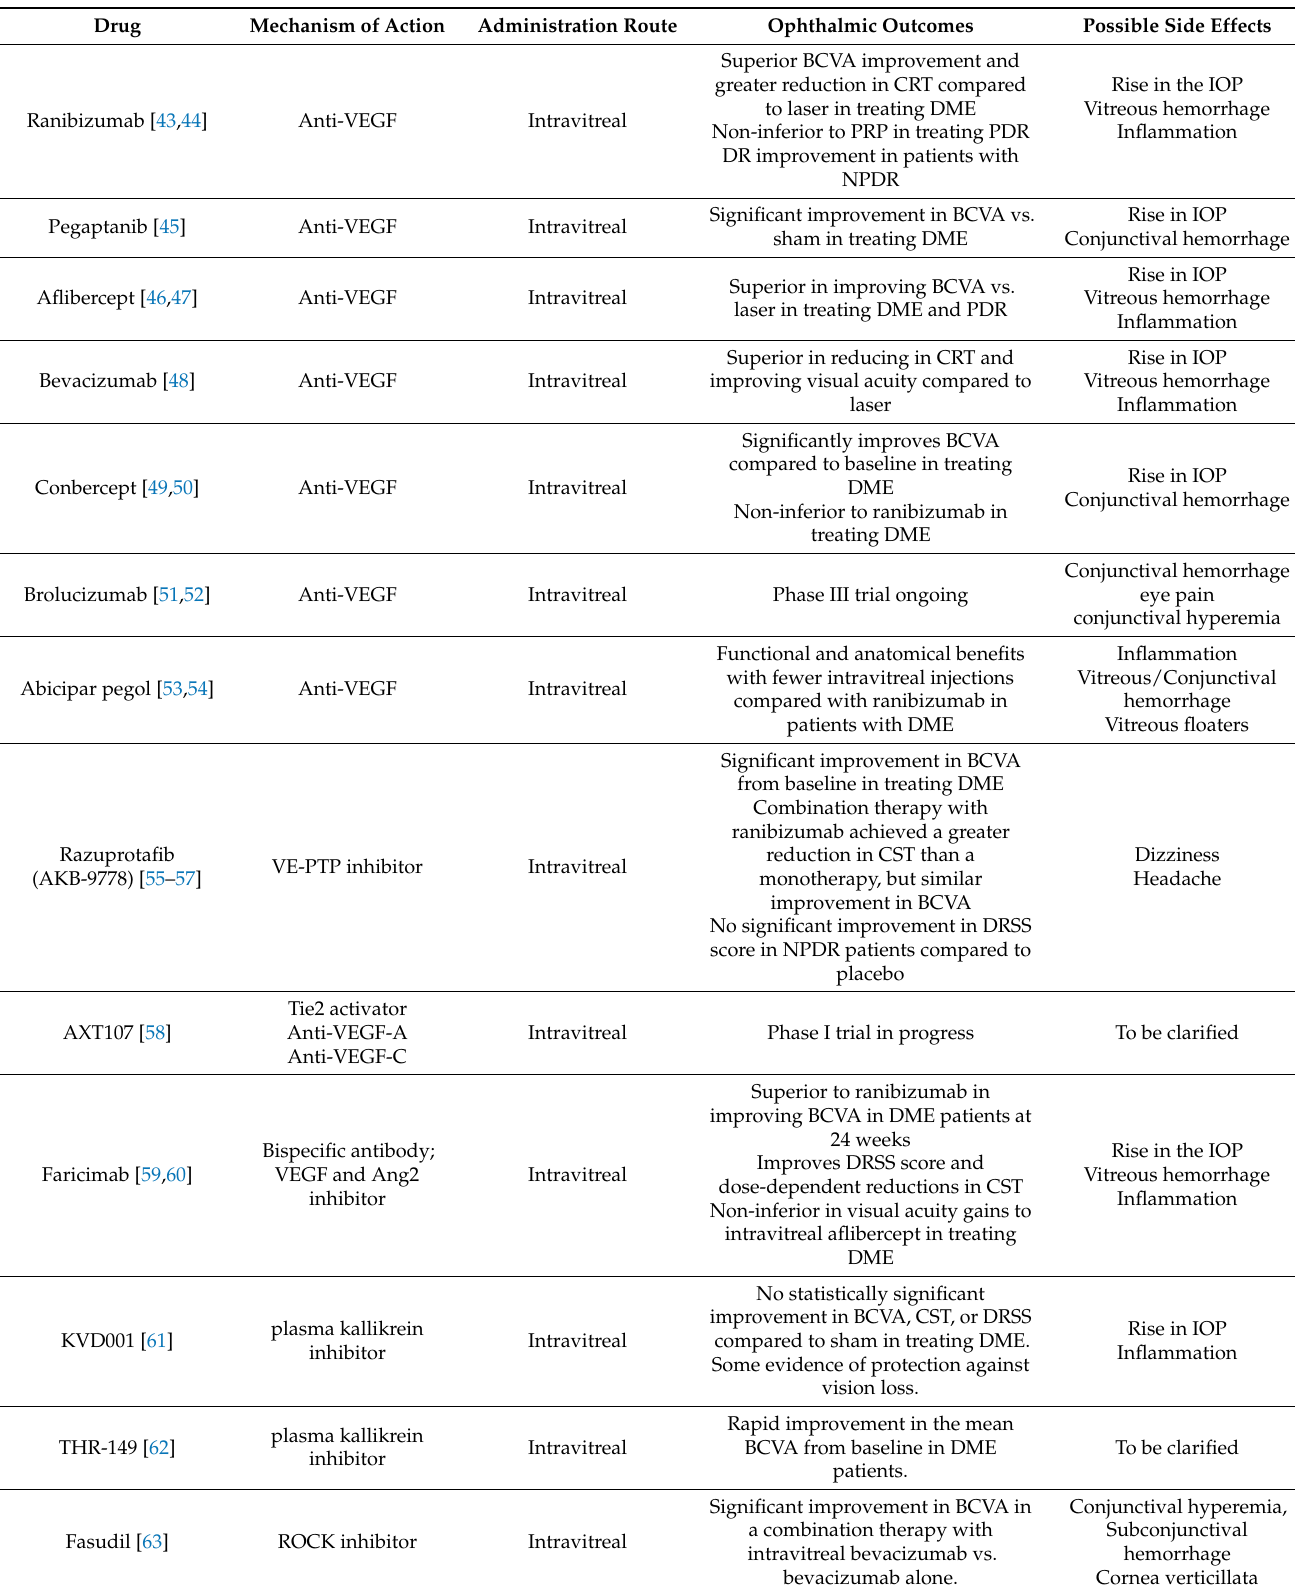
Table 1. Anti-angiogenic agents for treatment of DR and